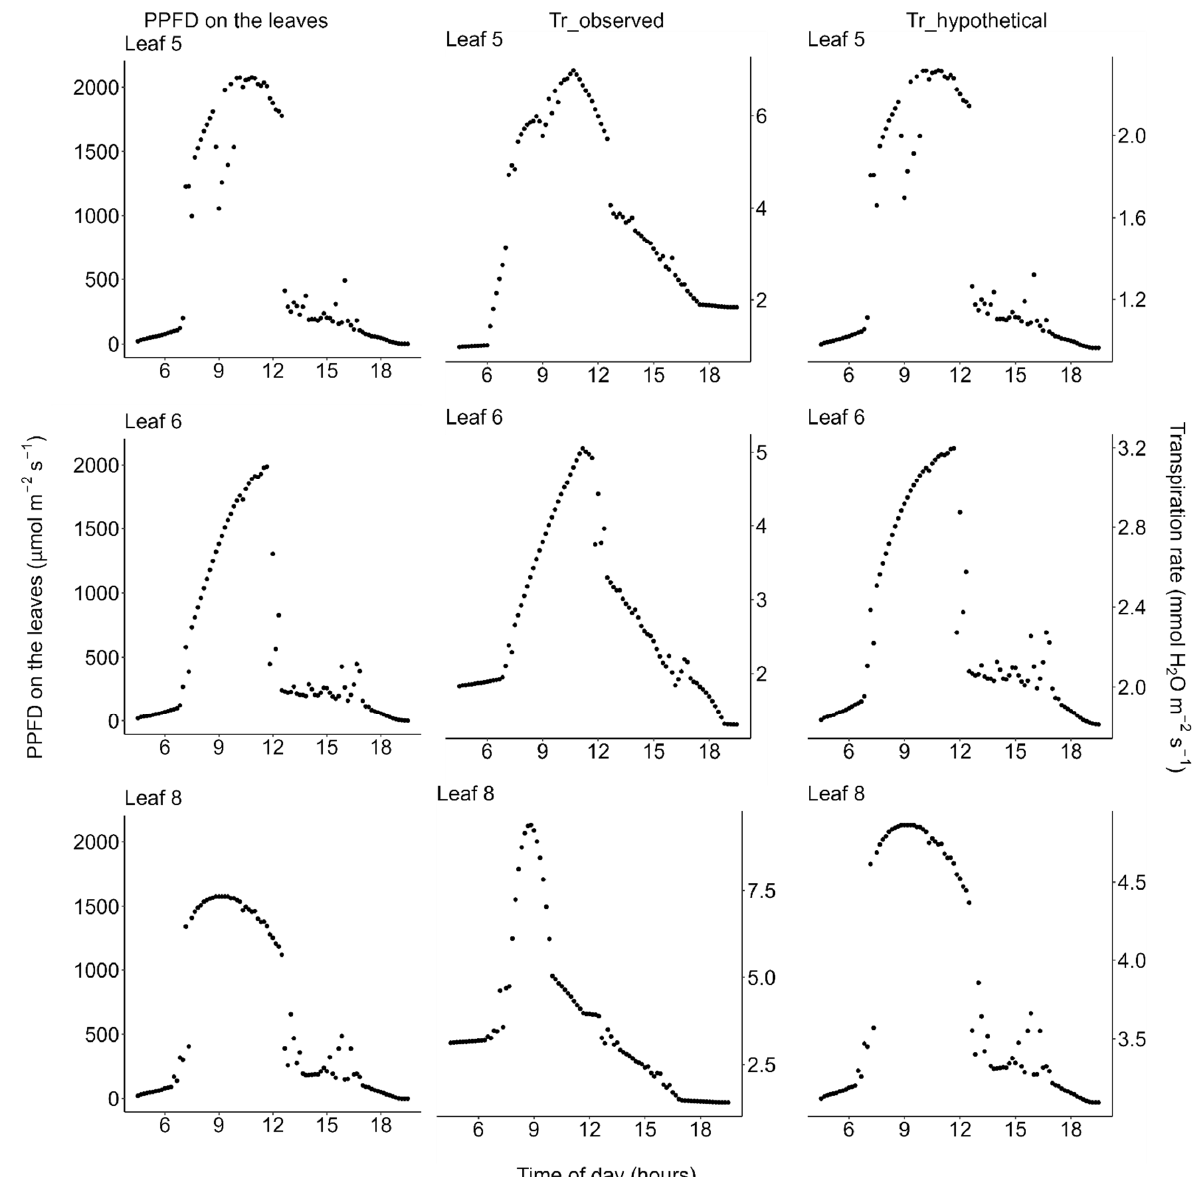
Figure 7. Diurnal courses of transpiration on the very hot days (18 and 19 July 2021). ( Left ) Photo- synthetic photon flux density (PPFD) incident on each leaflet of Menyanthes trifoliata , ( middle ) T r_observed : actual transpiration rate per unit area of leaf calculated based on both the observed diurnal change of PPFD-transpiration response curve (Figure 2) and the diurnal change of PPFD, and ( right ) T r_hypothetical : simulated transpiration rate calculated by holding the PPFD-transpiration response curve constant throughout the day, fixed at the curve observed in the early morning for each leaflet (Figure 2). Note that: (1) PPFD was measured on 18 July and the PPFD data were used to estimate transpiration on 19 July, the day on which the light-response curves shown in Figure 2 were measured, and (2) in the afternoon, the plants were shaded by trees on the pond shore (see Figure 1 for detailed weather conditions). All data are available in the Supplementary